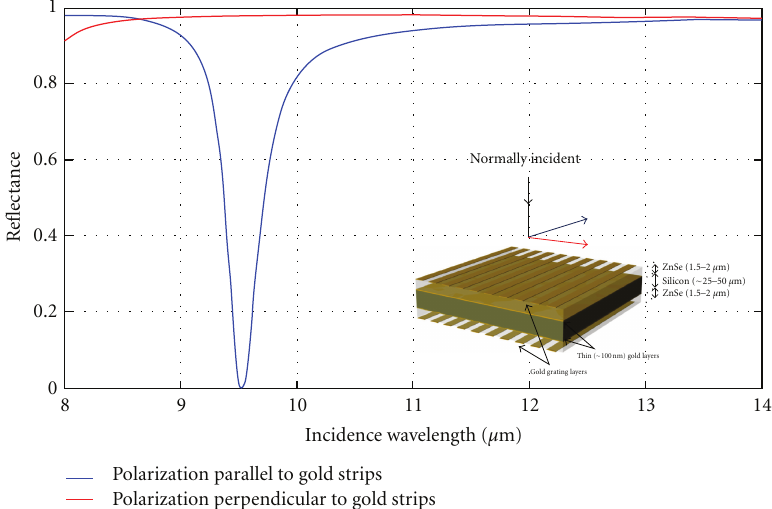
Figure 3: Simulation results, using the RCW method, that present the reflectivity at normal incidence within the LWIR band. The reflectivity as expected is polarization dependent due to the anisotropic nature of the